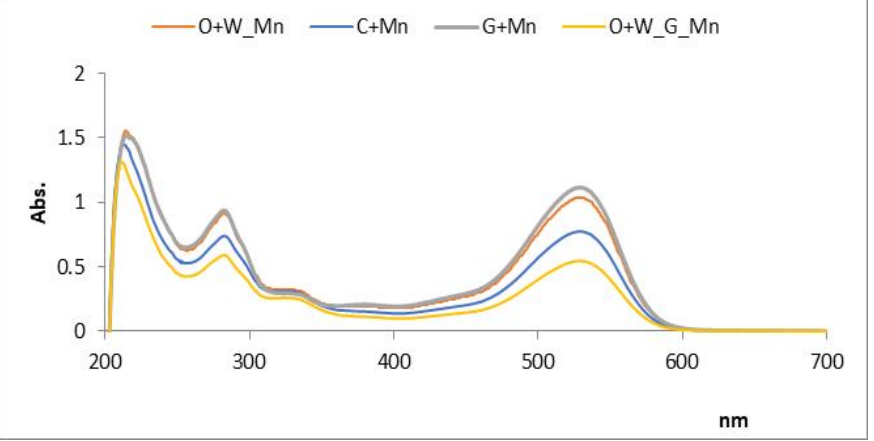
Figure 5. The UV-Vis absorption spectra for anthocyanins in mulberry extracts with different coating treatments after 8 days of storage.